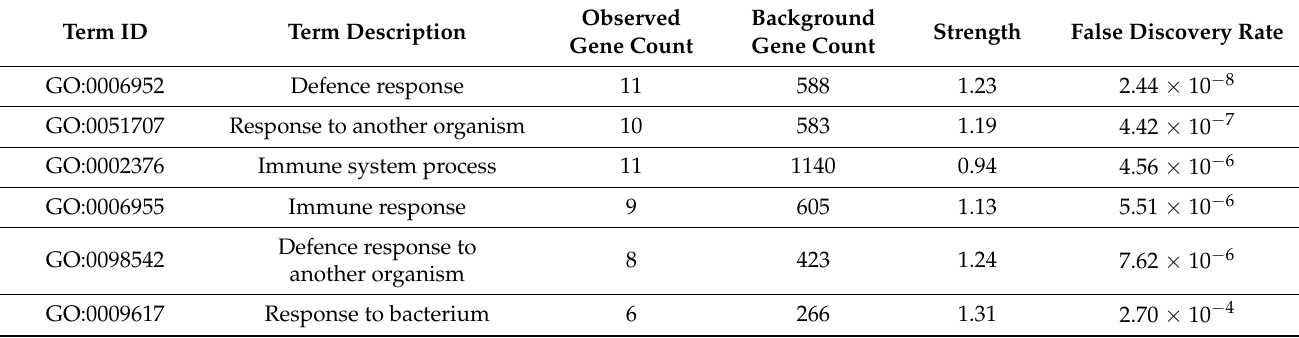
Figure 2. Analysis of the relationship (network) between proteins encoded by genes whose expression was analysed in the current study. Lines represent protein-protein associations. Lines of interactions according to String software: light blue—from curated databases; pink—experimentally determined; dark green—gene neighbourhood; red—gene fusions; dark blue–gene co-occurrence; light green–text mining; black—co-expression; violet—protein homology. Table 5. Functional enrichment in gene network based on Gene Ontology terms (Biological Process) created by String